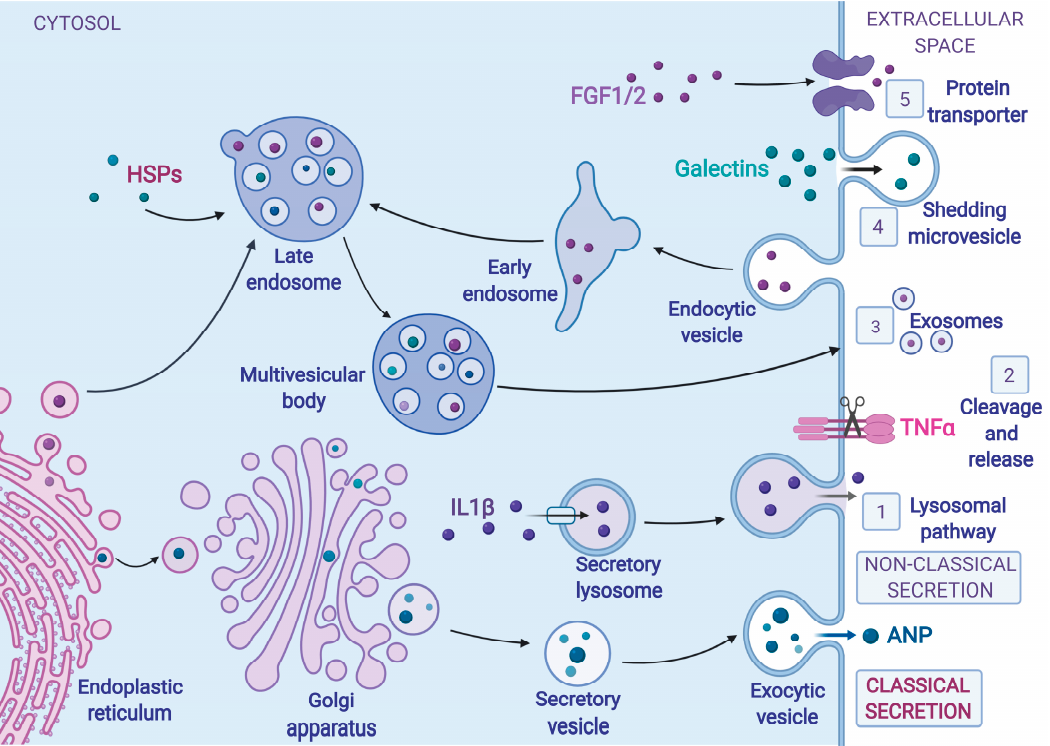
1 Figure 1. Mechanisms of Cardiokine Secretion. Cardiokines (secreted proteins from cardiac cells), such as atrial natriuretic protein (ANP), made at the endoplasmic reticulum (ER), are conventionally transported to the Golgi apparatus, where they are modified and packaged into secretory vesicles and then to the plasma membrane, where they are released into the extracellular space, in what is known as classical protein secretion. Some cardiokines that enter the ER bypass the Golgi apparatus, in some cases entering membrane-bound organelles such as endosomes, on their way to the plasma membrane. Cardiokines secreted via the non-classical secretory pathway are synthesized on cytosolic ribosomes and tra ffi c through various kinds of either vesicle- or nonvesicle-mediated pathways, without transiting through the ER and the Golgi apparatus. Non-classical protein secretion pathways include (1) incorporation into the lysosomal pathway, for example, interleukin 1 β (IL1 β ), (2) cleavage and release from a membrane-bound precursor, for example, tumor necrosis factor α (TNF α ), (3) release via exosomes derived from multivesicular bodies, for example, heat shock proteins (HSPs), (4) membrane blebbing and microvesicle shedding, for example, galectins, and (5) direct translocation of proteins across the plasma membrane through membrane transporters, for example fibroblast growth factor 1 and 2. Figures were created with